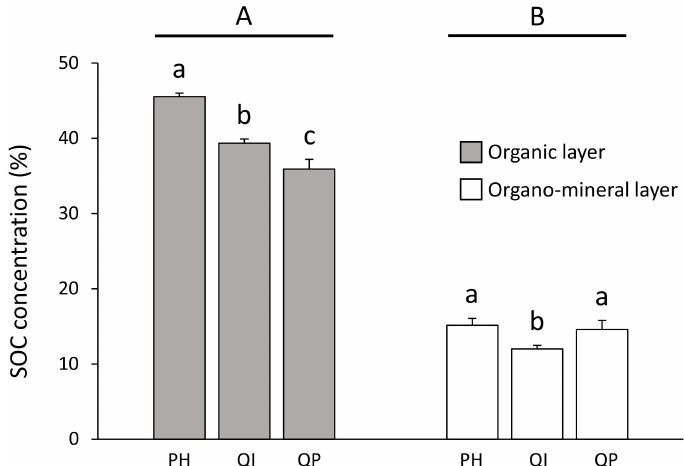
Figure 3. Soil organic carbon concentration according to the significant forest type × soil layer interaction (Table 3). Data are mean values ± SE and expressed as % per g of DW soil; n = 30. Different capital letters denote significant differences between soil layers with A > B (post hoc Tukey tests results). Different lowercase letters denote significant differences between forest types for each soil layer with a > b > c (post hoc Tukey tests results). SOC—soil organic carbon, PH— Pinus halepensis , QI— Quercus ilex , QP— Quercus pubescens .